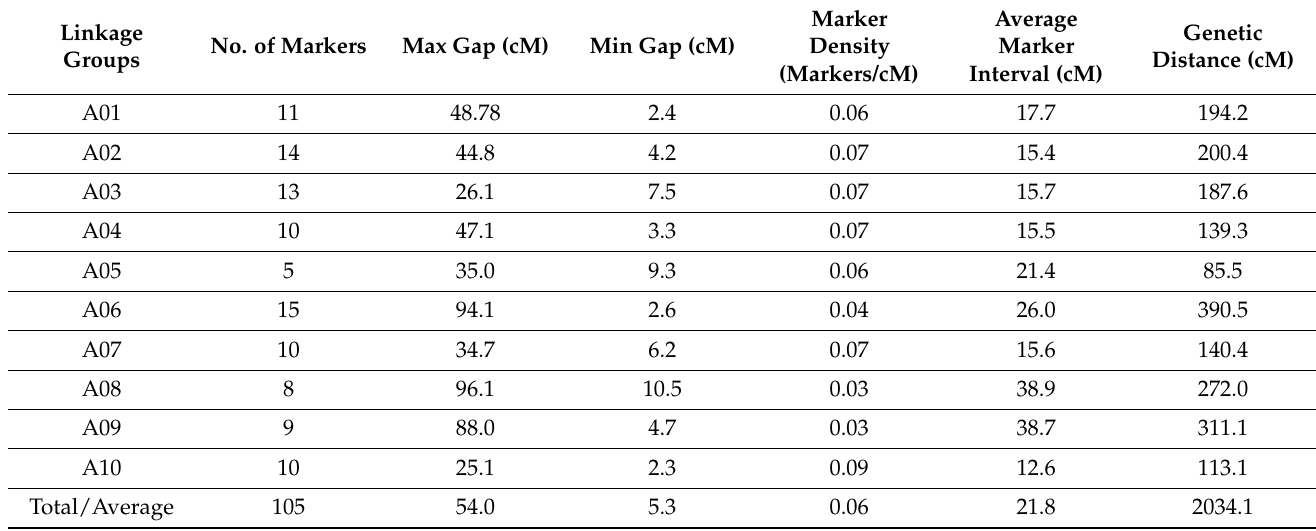
Table 2. Features of the EST-SSR-based genetic linkage map of Brassica rapa